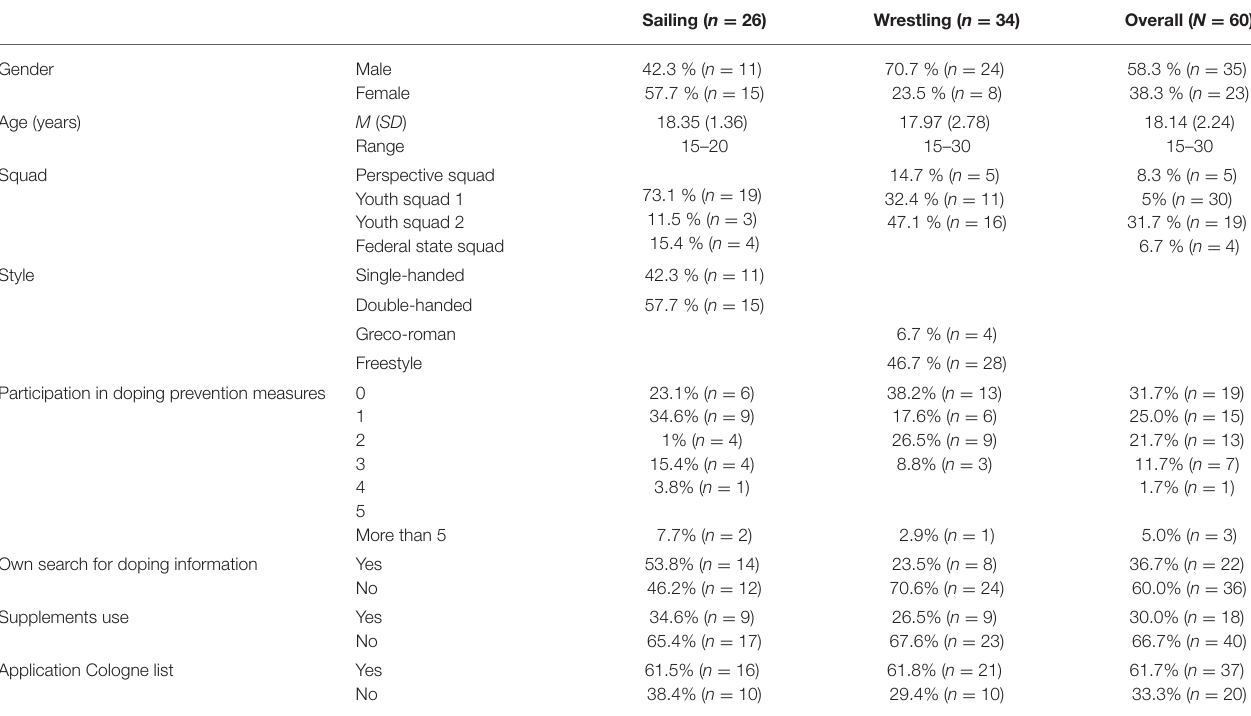
TABLE 1 | Characteristics of the